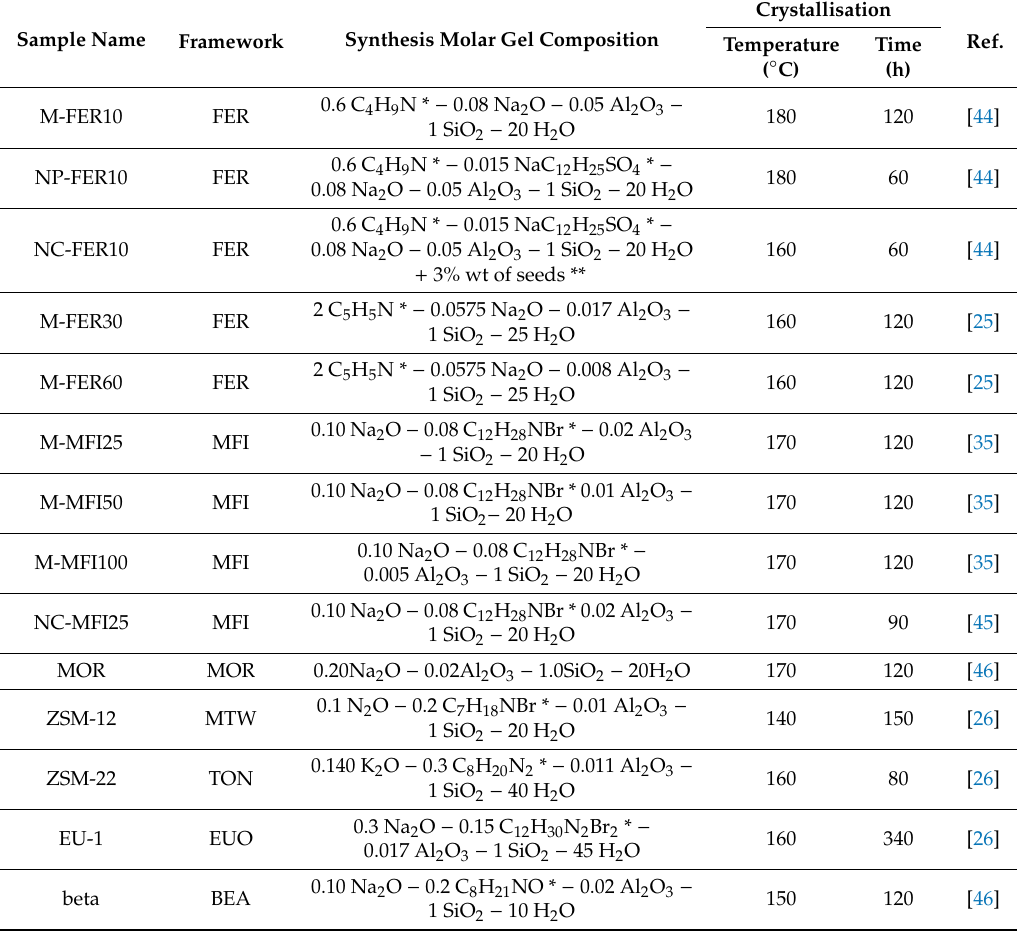
Table 2. Gel composition, temperature and time of crystallisation of the